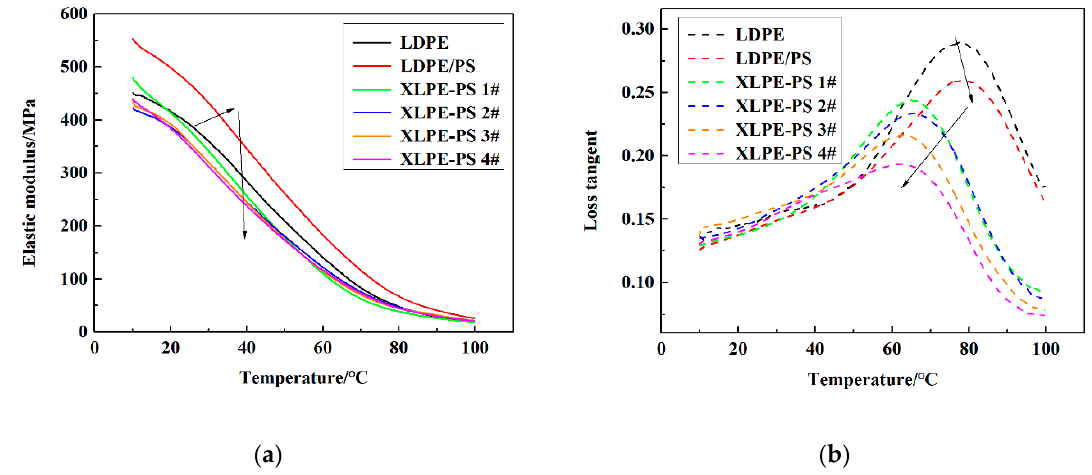
Figure 8. Dynamic mechanical behaviors of samples with different DCP contents: ( a ) elastic modulus; ( b ) loss tangent.